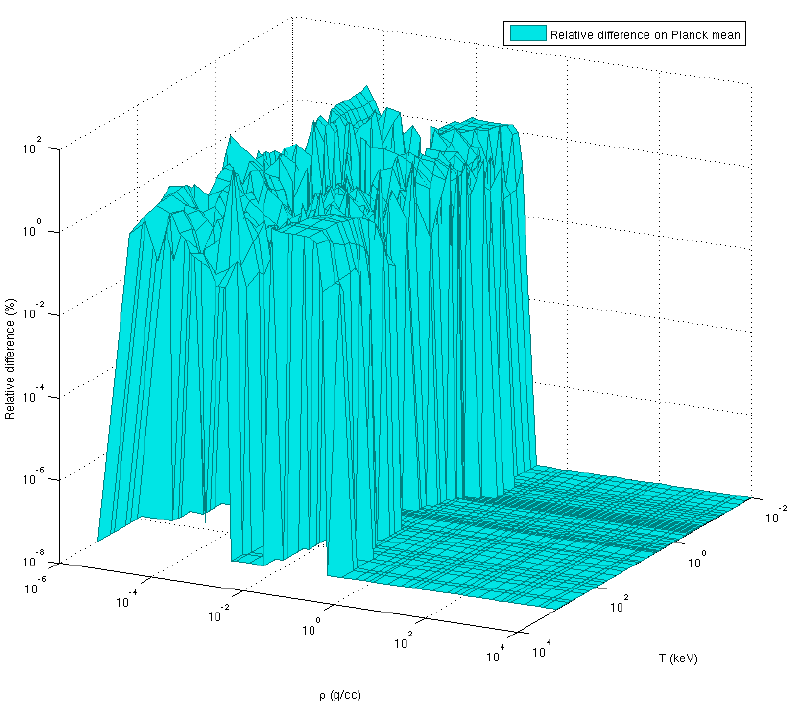
Figure 21. Maximum value of the relative difference (in absolute values) between the iron Planck mean opacities of a calculation with a maximum number of 1000 superconfigurations and a maximum number of 10,000 superconfigurations as a function of temperature and density.